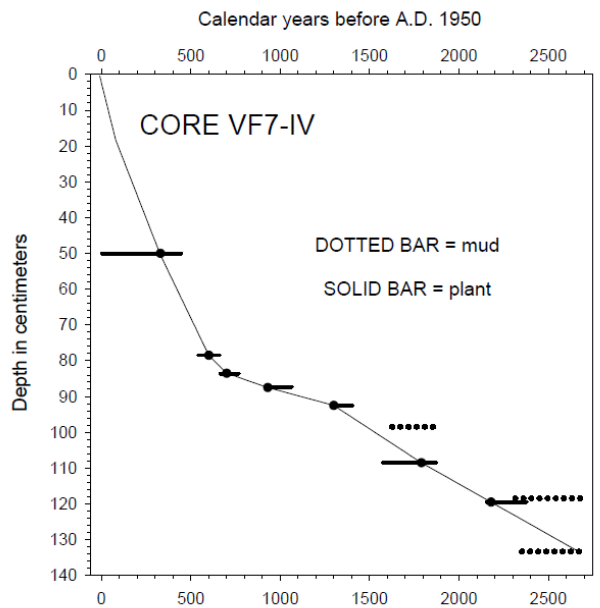
Fig. 5. Age-depth model for core VV09. The 2-sigma calendar age ranges for AMS dates on plant remains (black bars) and bulk sediment (dotted). The sediment-water interface was intact, so the curve meets the